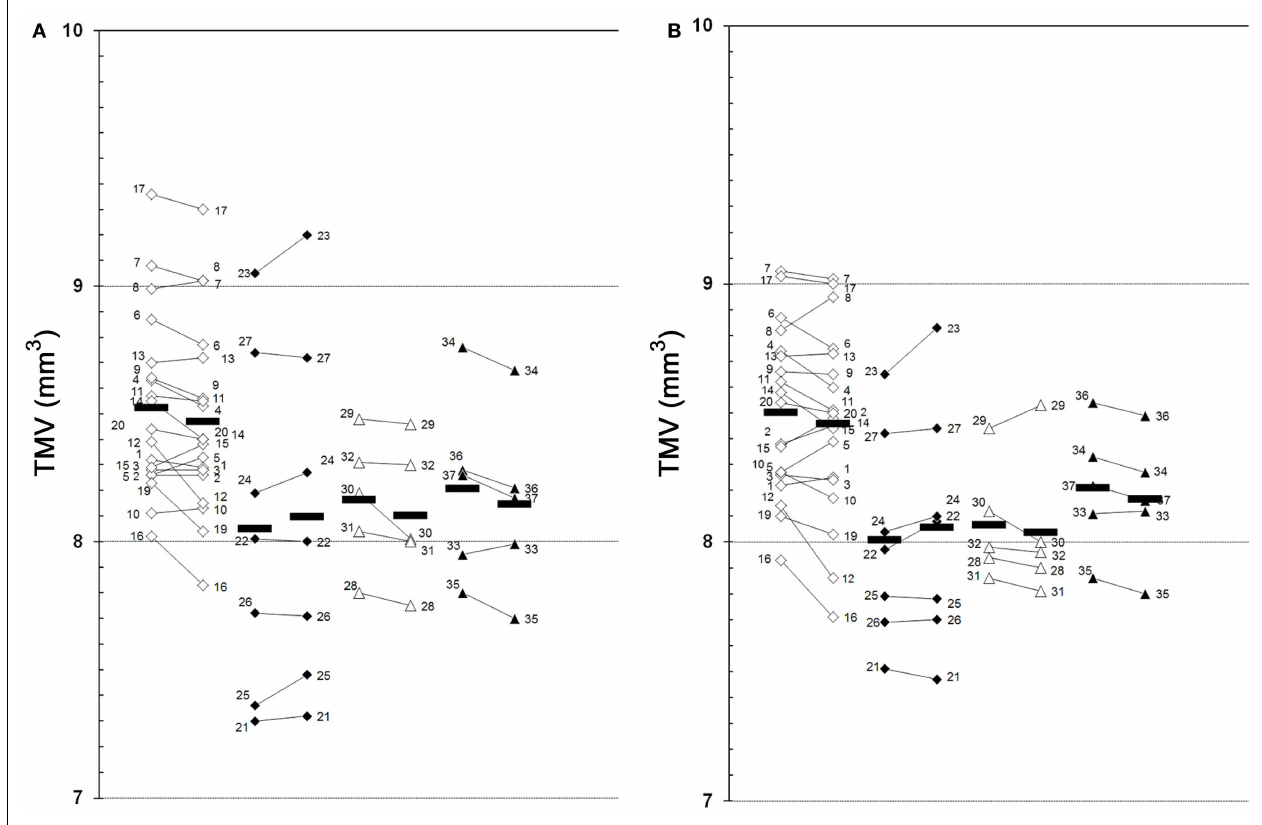
(baseline follow-up); black squares, RRMS with ON (baseline follow-up); white triangles, SPMS without ON (baseline follow-up); black triangles, SPMS with ON (baseline follow-up); black bars,